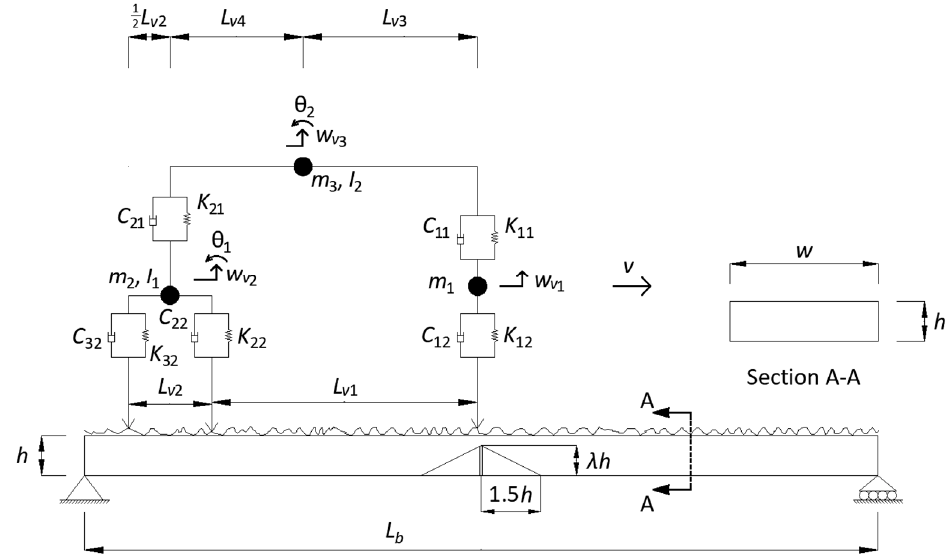
Figure 1. Vehicle-bridge interaction